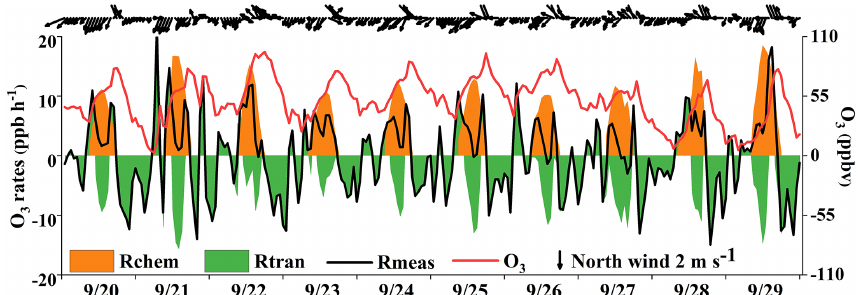
Figure 11. O 3 accumulation and contributions from local photochemical production and regional transport. R chem , R tran , and R meas in the legend represent local O 3 photochemical production, regional transport, and observed O 3 formation rate,